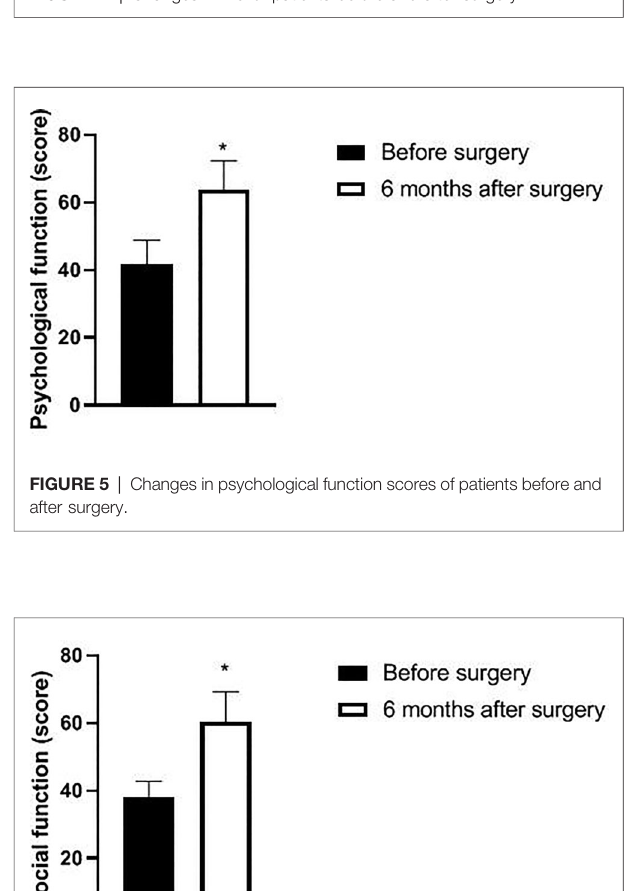
FIGURE 4 | Changes in RU of patients before and after surgery.